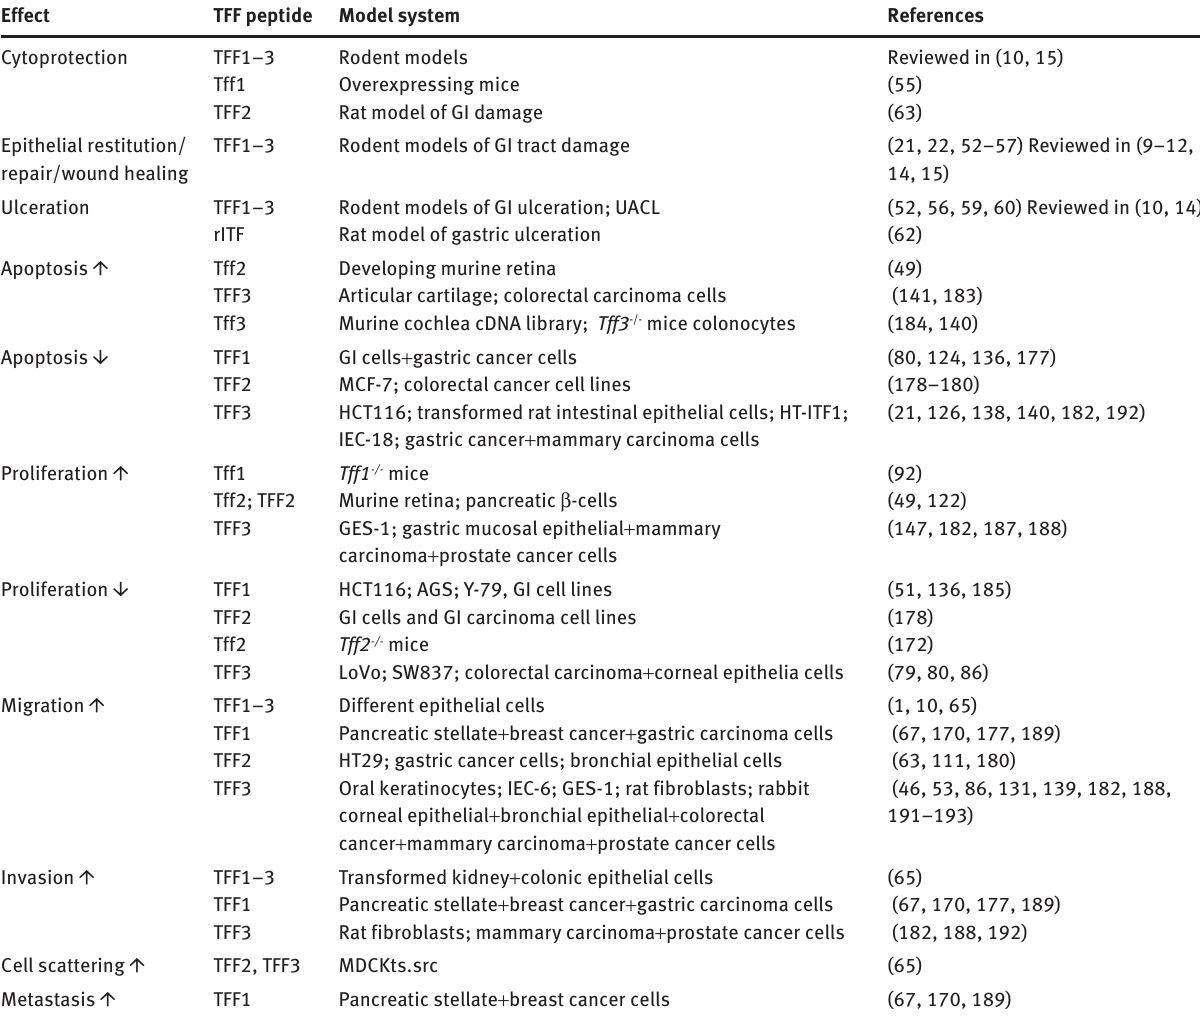
Table 1: Summary of major confirmed effects of TFF